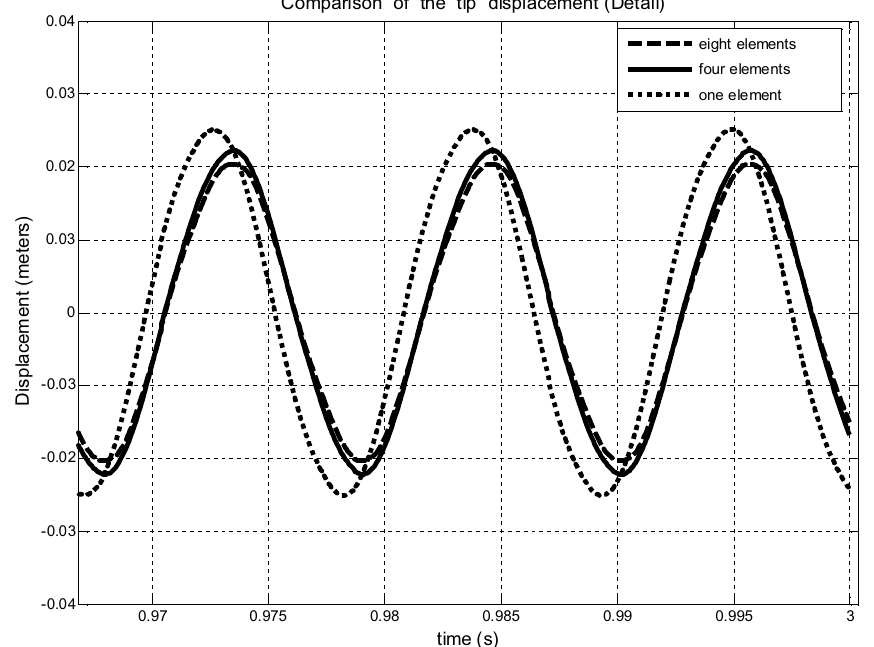
Fig. 7. Tip displacement with respect of time